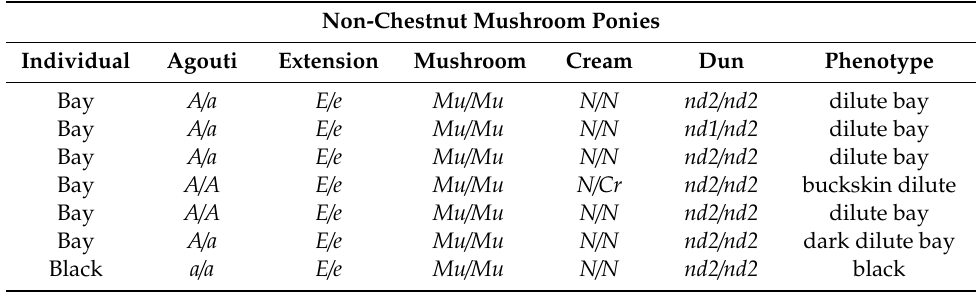
Table 6. Ophthalmic Findings in Mushroom Ponies. A complete ocular exam was performed on twenty Shetland Ponies Genotypes for coat color with variation in the sample set are also reported.